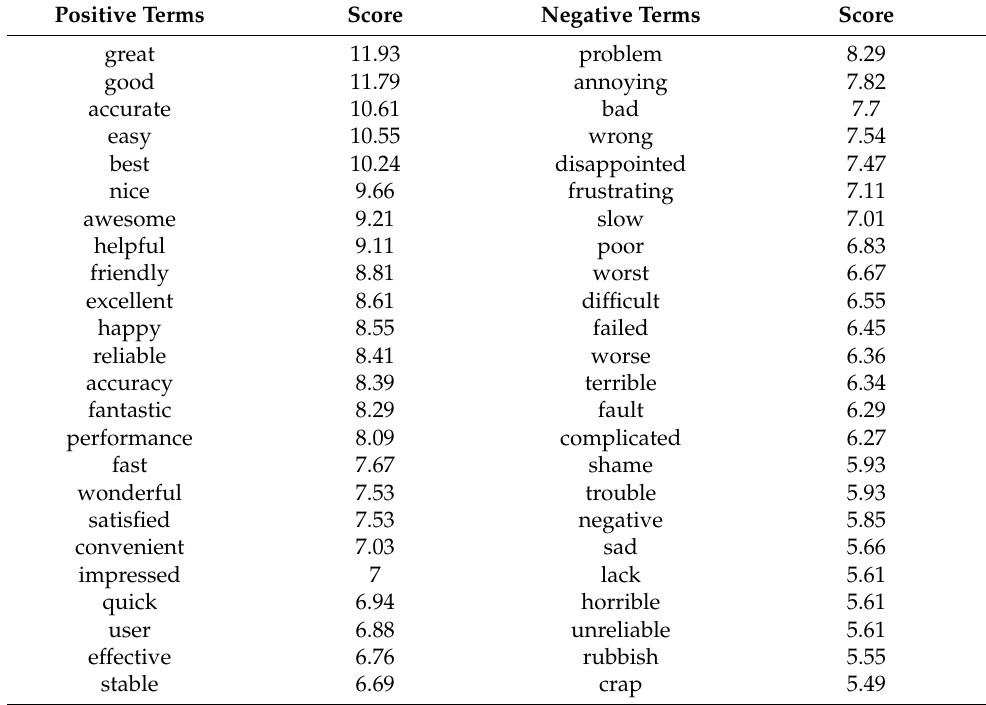
Table 2. Sentiment analysis